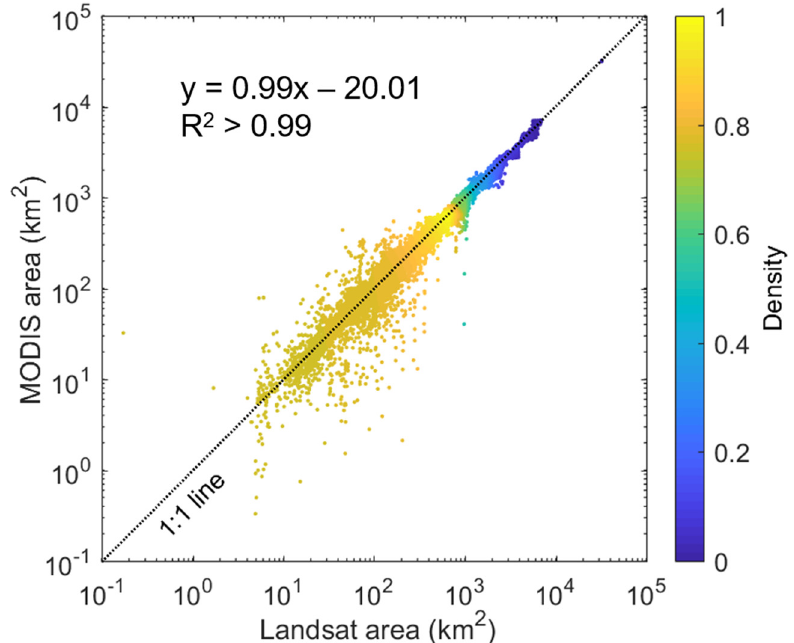
Figure 5. The density plot of monthly area estimations between Landsat and Moderate Resolution Imaging Spectroradiometer (MODIS) from February 2000 to December 2018 for the 164 reservoirs. Note that the x-axis and y-axis use a logarithmic scale, and there are a total of 37,228 (227 × 164) pairs.